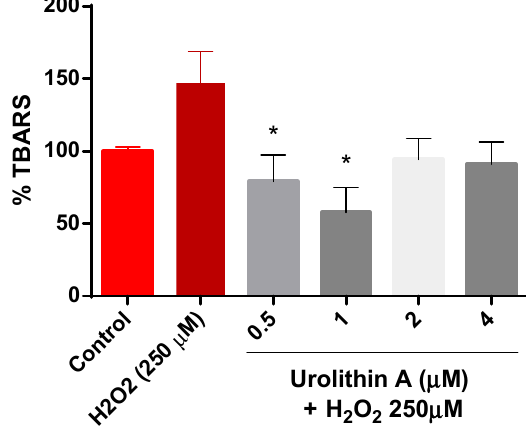
Figure 3. ROS production in Neuro-2a cells subjected to oxidative stress by hydrogen peroxide (250 µ M) and treatments with urolithin A (0.5–4 µ M). Data are expressed as percentage over control cells and the assay was carried out for 90 min in order to measure intracellular ROS production. Note: # p < 0.005 versus control; ## p < 0.001 versus control. Significant differences appeared at the starting point for H 2 O 2 -N2a cells over control cells ( p < 0.001). However, pre-treatments with 0.5 and 2 μ M urolithin A at 0 and 10 min were associated with significant differences ( p < 0.01). After 20 min, significant differences were reached at 1 μ M ( p < 0.01). Finally, 4 μ M of the antioxidant exhibited significant